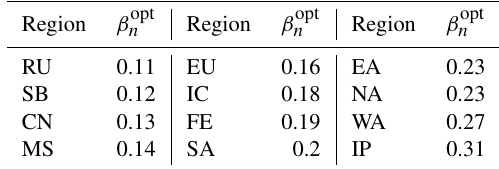
Table 2. Optimal PV share for each autonomous node. Region